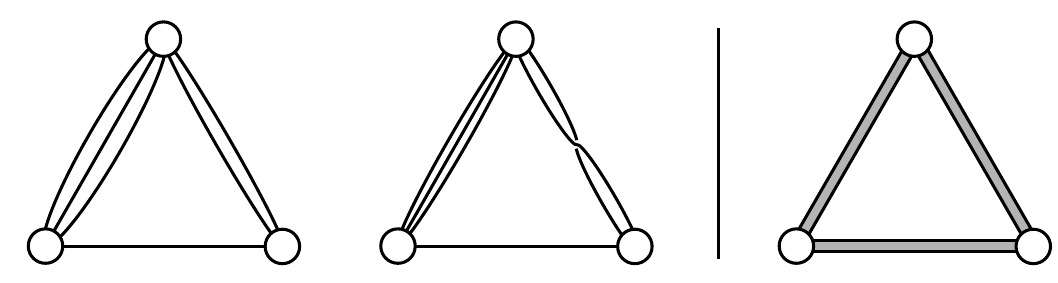
Figure 6 . Skeleton reduction of a Feynman graph. Planar Wick-contractions (left) and non-planar consecutive Wick-contractions (center) are reduced to the same skeleton graph